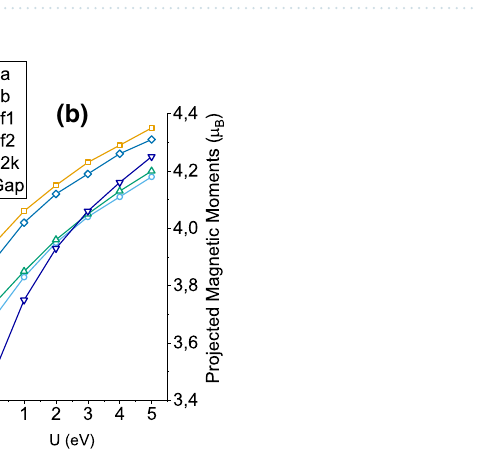
Figure 1. Atomic structure of the SFO. The unit cell contains two formula units, ( SrFe 12 O 19 ) 2 , and has 64 atoms in total. The environement around each Fe ion has been shaded in order to highlight its coordination to oxygen atoms (tetrahedral, octahedral or bipyramidal). This figure has been obtained using VESTA 20 version 3.5.1 (https ://jp-miner als.org/vesta /en/).